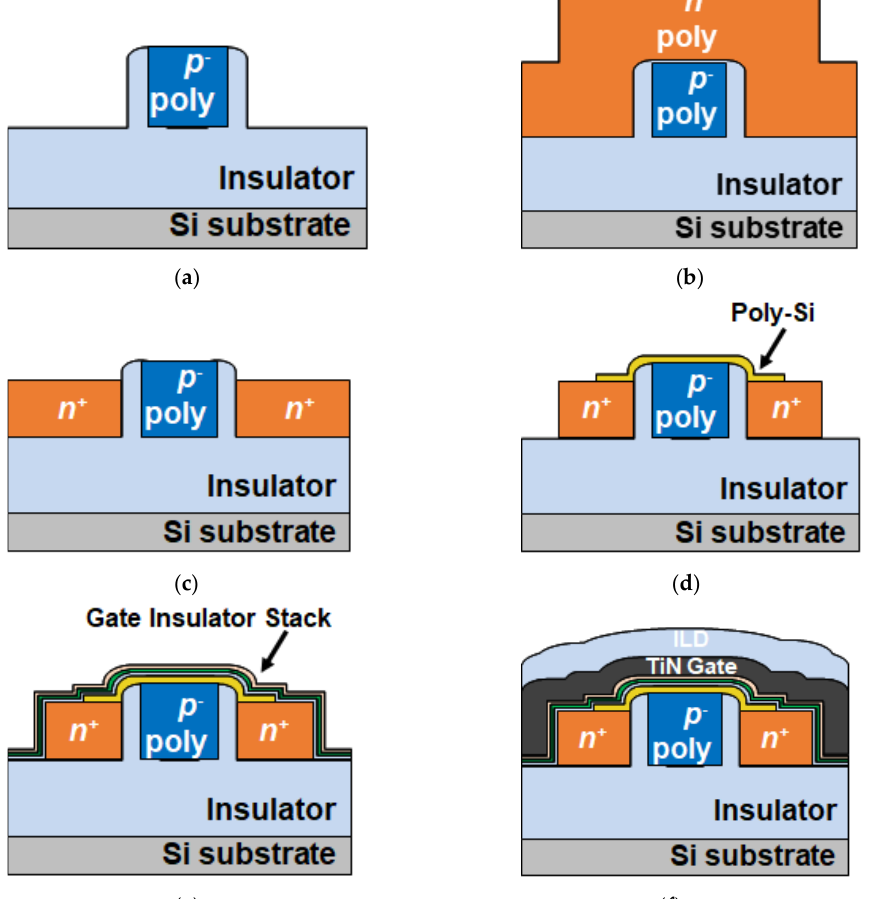
Figure 2. Schematic process cross-section of an eFlash cell fully compatible with CMOS process: ( a ) p -body formation via LPCVD and implantation; ( b ) n + poly-Si deposition via LPCVD; ( c ) CMP & CDE; ( d ) poly-Si channel formation; ( e ) gate insulator stack formation; ( f ) metal gate via MOCVD & inter layer dielectrics (ILD).